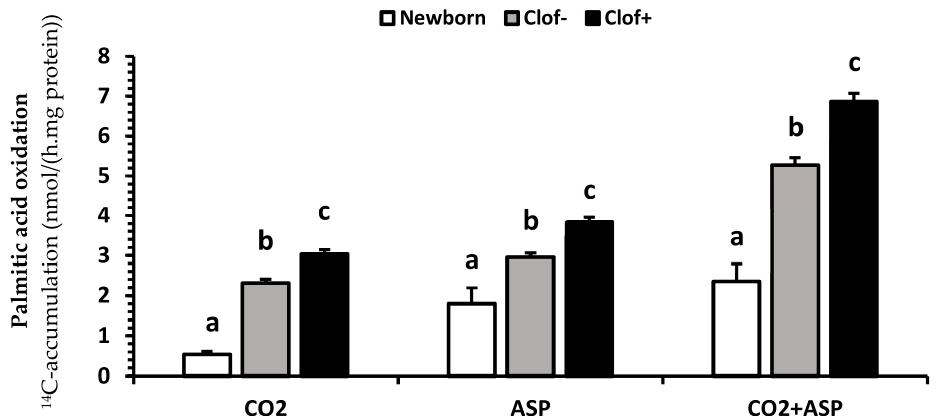
Figure 1. The main effect of clofibrate on palmitic acid oxidation. Data (Lsmeans ± SEM) are 14 C-accumulations in CO 2 , acid soluble products (ASP) and CO 2 + ASP ( n = 32). abc Treatments (newborn, clof − (no clofibrate supplementation) and clof+ (clofibrate supplementation)) for CO 2 , ASP and CO 2 + ASP with different superscripts differ ( p < 0.05). Supplementation of TriC6 in the milk replacer also increased the palmitic acid oxidation ( p < 0.001). The 14 C accumulations (nmol / (h.mg fresh tissue protein)) on average in CO 2 , ASP, and CO 2 + ASP were 25%, 24%, and 25% higher in kidney from pigs fed the diet with TriC6 than the diets with GlySuc, TriC5, and Tri2MPA (Figure 2).